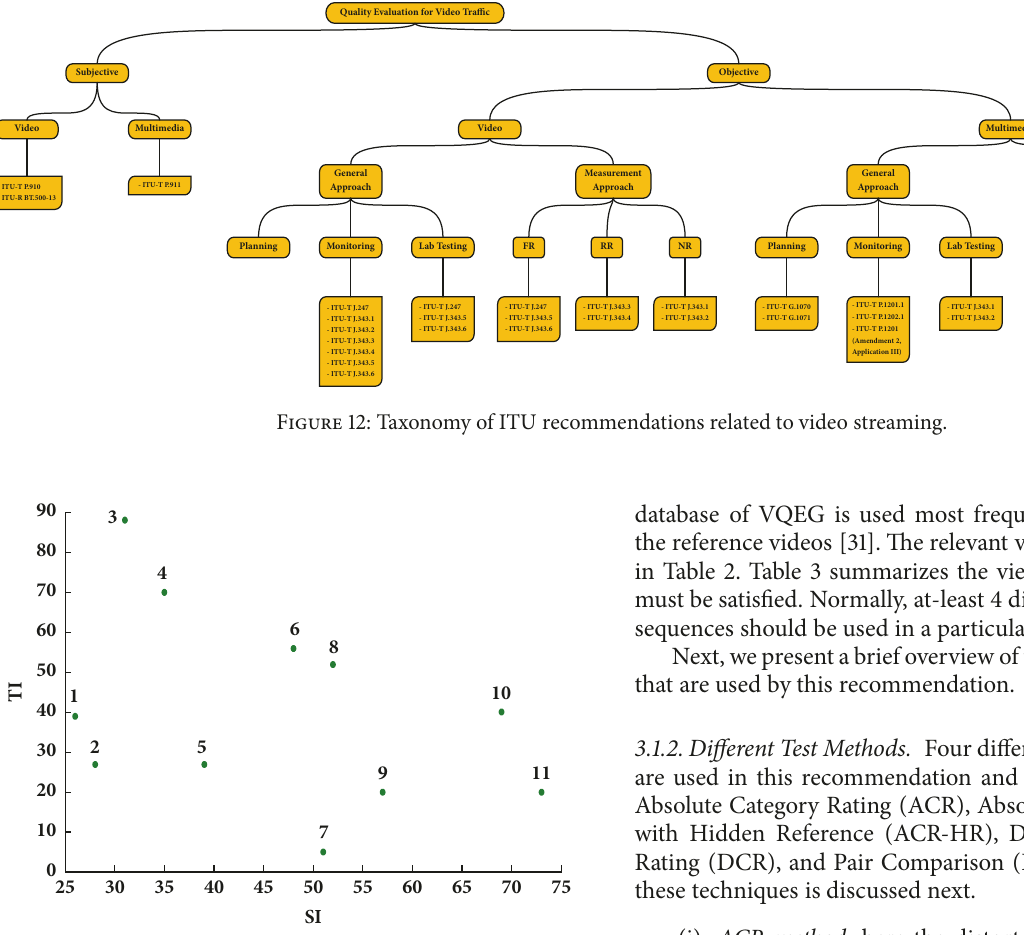
Figure 13: SI/TI values of some commonly used video sequences by ITU